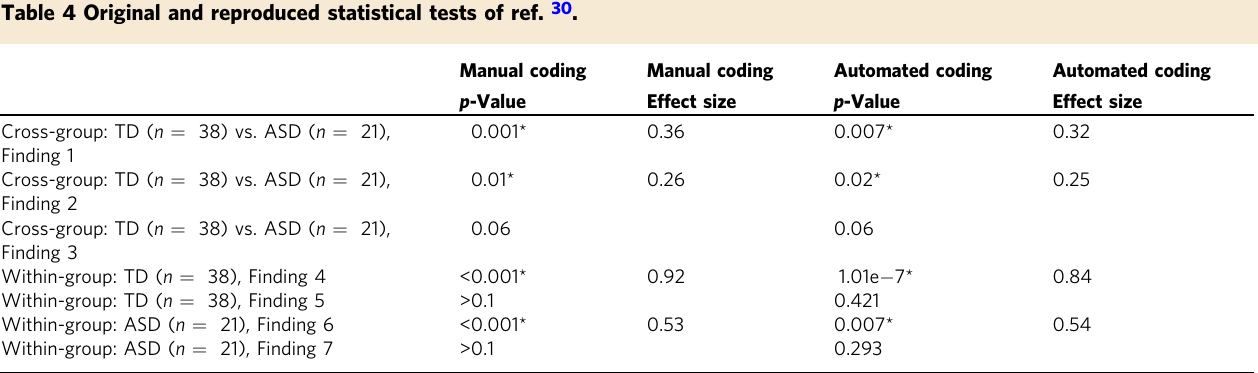
Table 4 Original and reproduced statistical tests of ref. 30 .